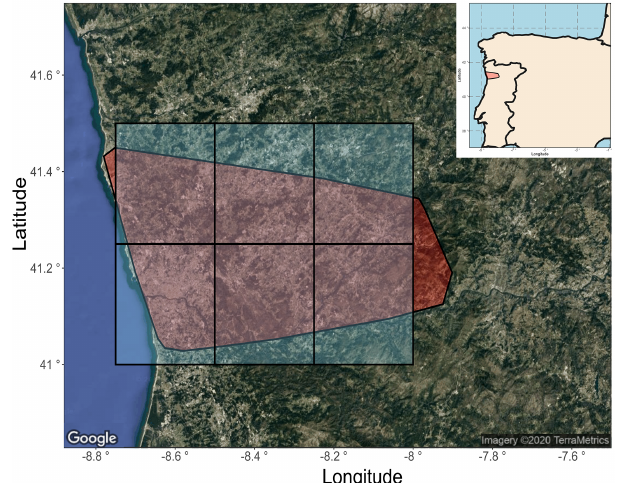
Figure 11. Portugal study area for the interrelation between extreme hot temperature and wildfire-burned areas. The red area represents Porto District in Portugal, containing the studied wildfire-burned areas. The blue tiles represent cells from the high-resolution gridded dataset of daily climates over Europe (E-OBS; Cornes et al., 2018) containing mean daily temperature data. Satellite image retrieved with ggmap (Kahle and Wickham, 2013). © Google Maps (2020).